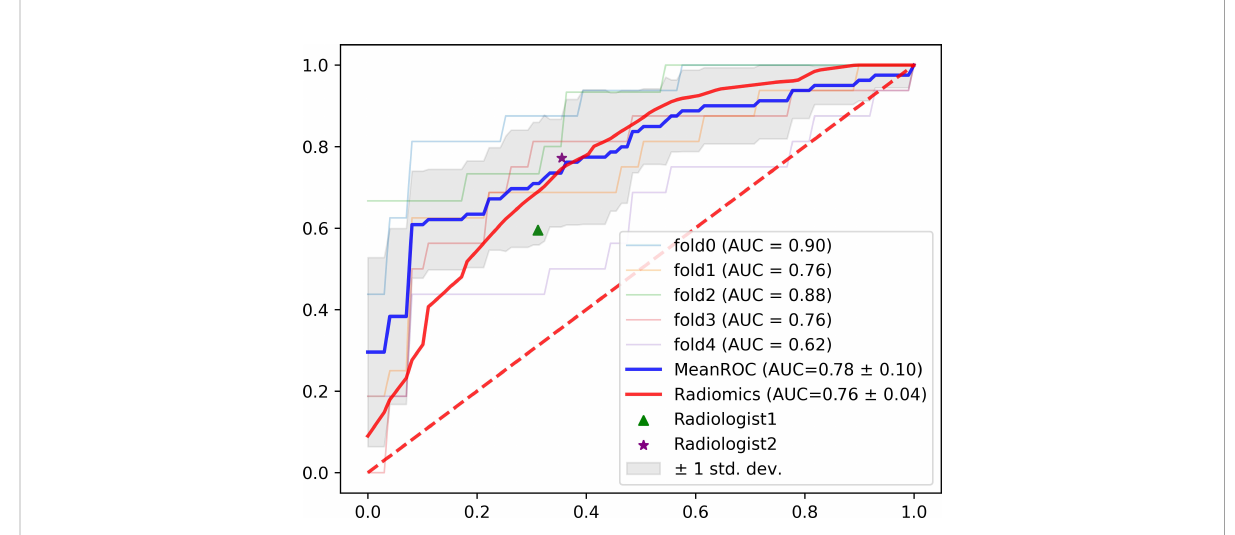
FIGURE 4 The ROC curves for the fi ve-fold cross validation experiments with the overall performance, radiomics model and radiologist